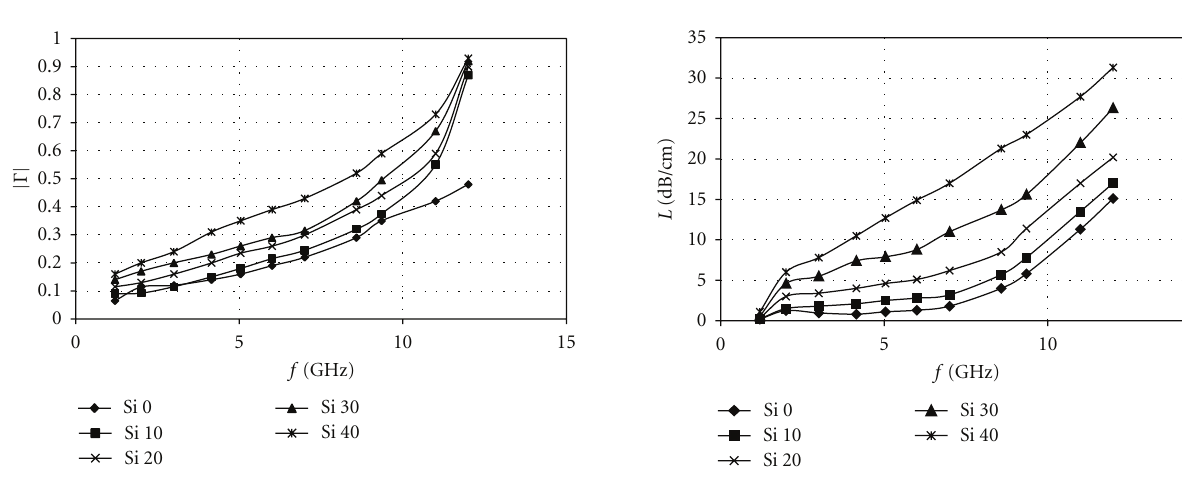
Figure 8: Frequency dependence of attenuation of electromagnetic waves at various filler content in the composites.